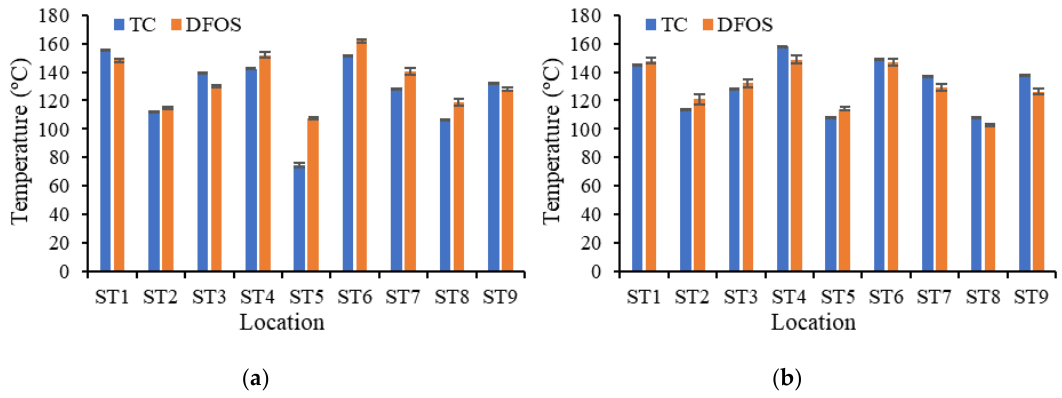
Figure 11. Comparison of temperature measurements from thermocouples (TC) and distributed fiber optic sensors (DFOS) deployed on the top surface of the concrete at 120 min: ( a ) CS-5, and ( b ) CS-6. The error bars depict the standard deviation of the temperature measurement results.